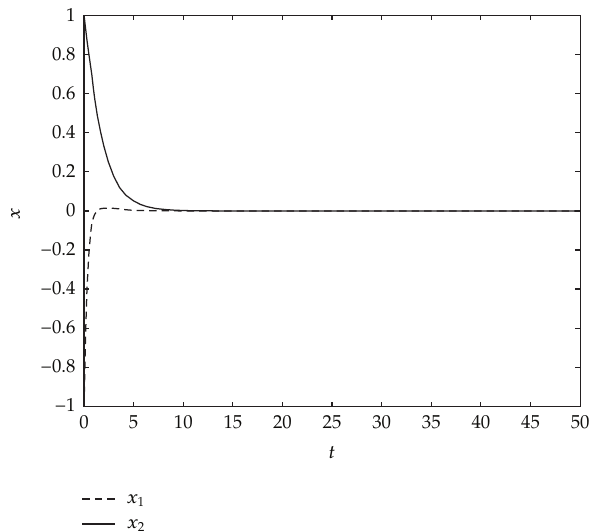
Figure 8: The trajectory of solution of system i (cid:8) 2 under the feedback controller (cid:6) 4.12 (cid:7)